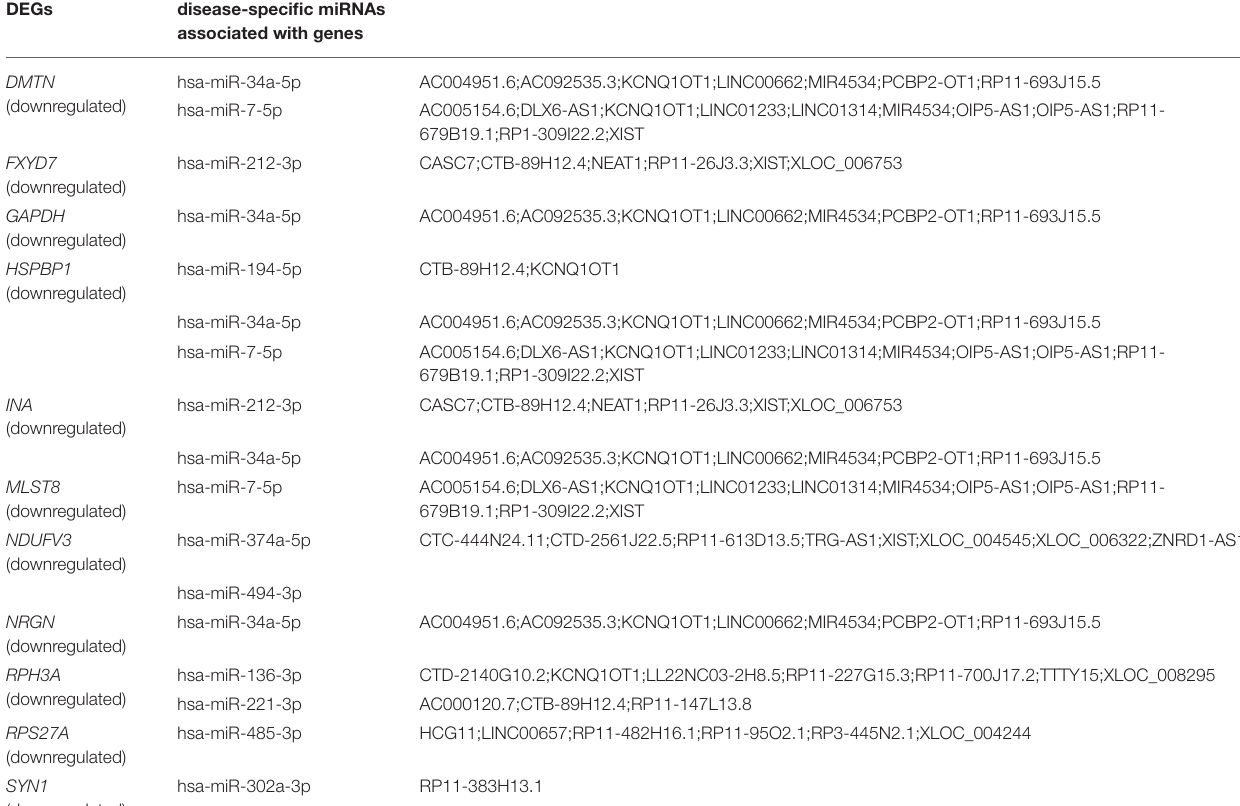
TABLE 8 | Other neurodegenerative disease-specific miRNAs associated with the AD-associate DEGs. AD-associate Other neurodegenerative lncRNAs associated with DEGs disease-specific miRNAs associated with genes